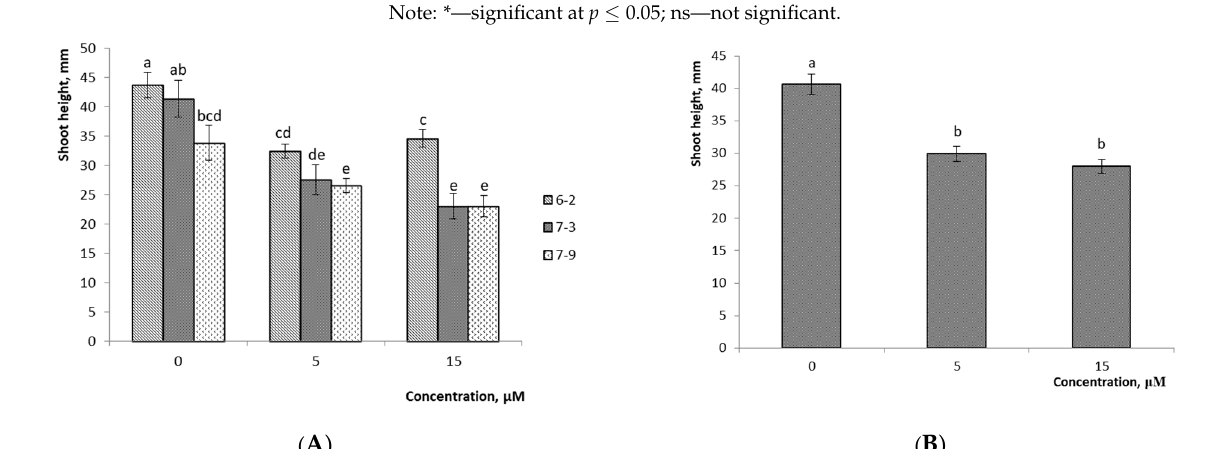
Figure 6. Effect of 2iP concentration on shoot height of V.ul. 8 × ‘NC’: ( A ) detailed analysis of values of hybrid variants; ( B ) average values of hybrid variants. Means followed by the same letter are not significantly different according to the LSD at p ≤ 0.05. Note: 1-1, 1-2, 1-5, 2-2, 4-2, 4-6, 4-8, 5-3—variant Nos. 1-1, 1-2, 1-5, 2-2, 4-2, 4-6, 4-8, 5-3.